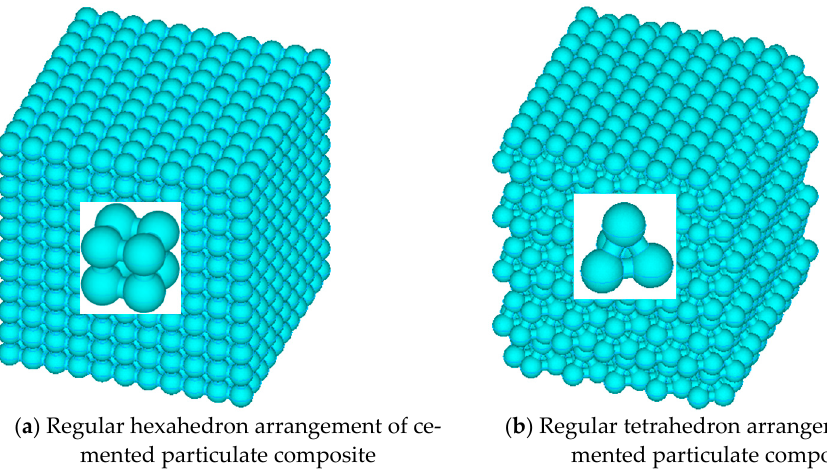
Figure 8. Schematic diagrams of two different arrangement forms of cemented particulate composite.